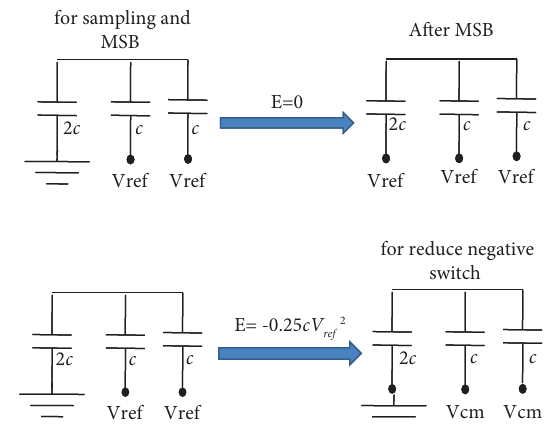
Figure 34: Two energy saving methods.